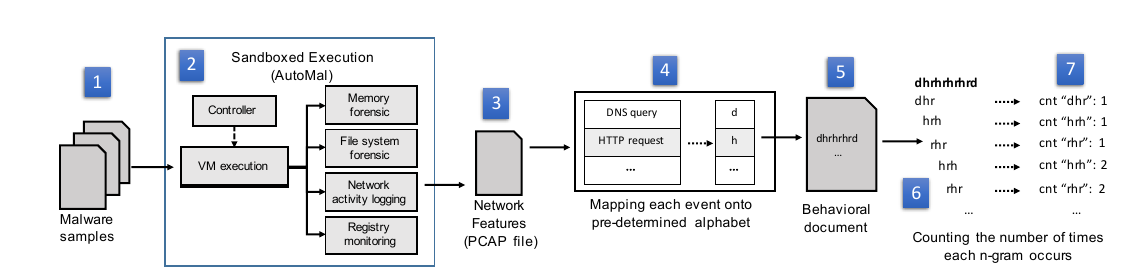
Figure 2. Chatter’s sandboxed execution and feature extraction utilizing the network profiling in AutoMal and n - gram-based features